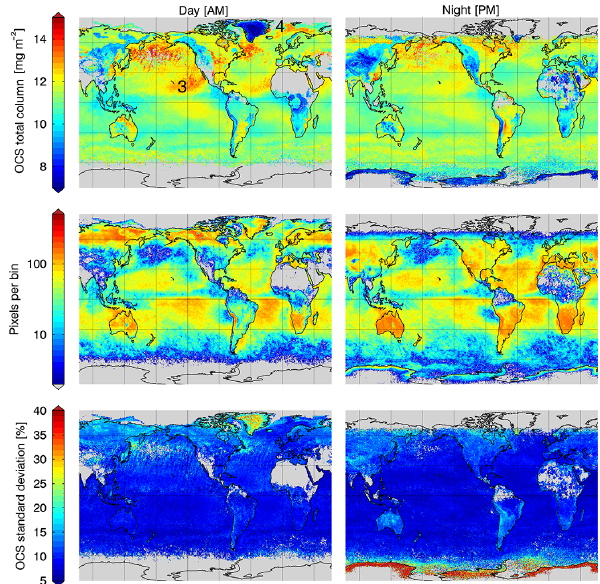
Figure 12. Same as in Fig. 10, but for May–June